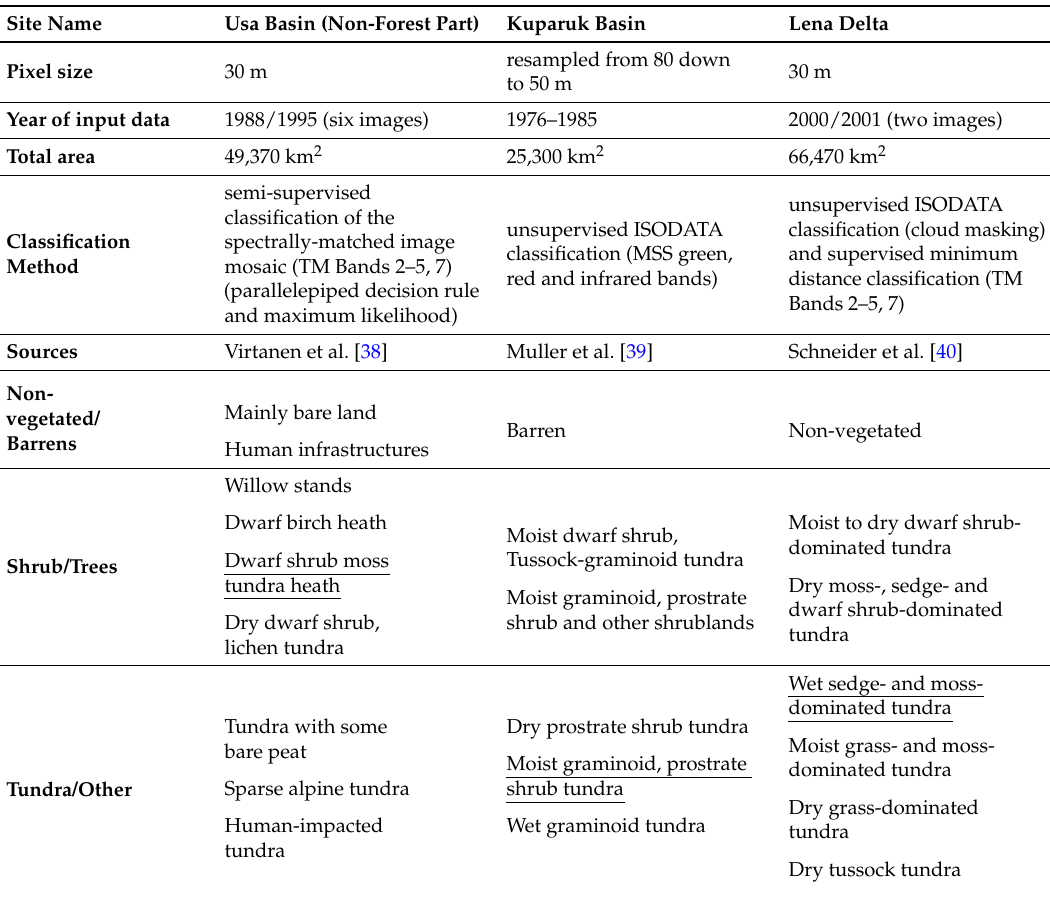
Table 1. Non-water classes of selected multi-purpose land cover classifications based on Landsat. The dominating land cover class is underlined. For the location, see Figure